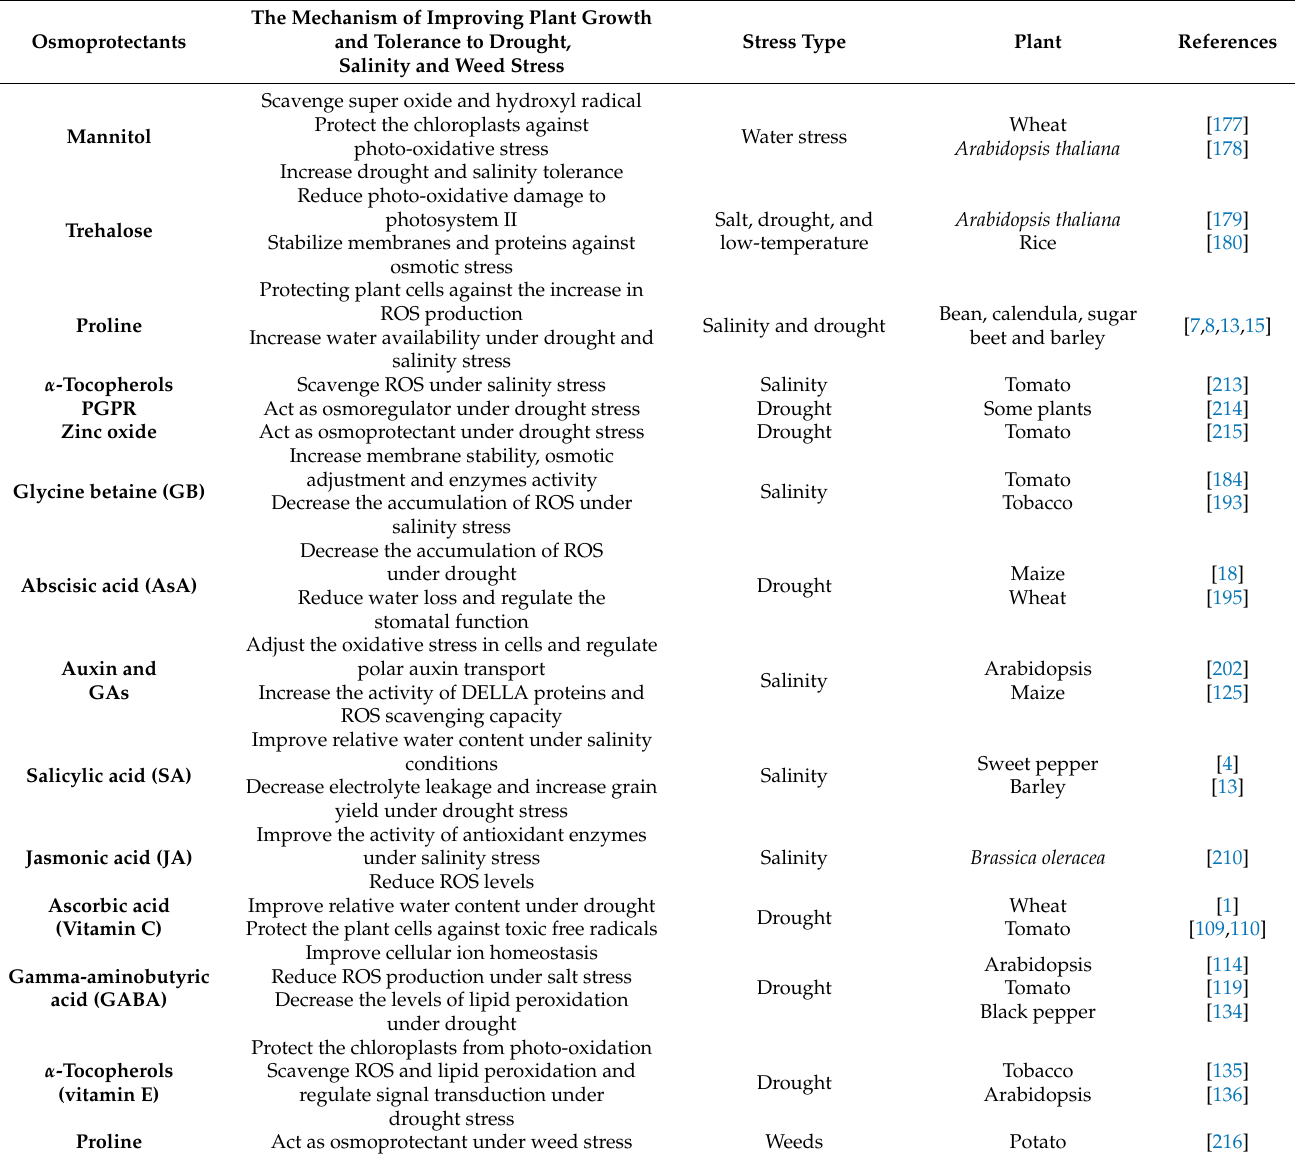
Table 2. The role of some osmoprotectants in improving the growth and tolerance to drought, salinity, and weed